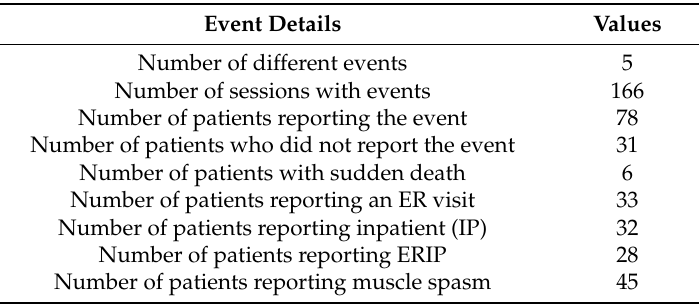
Table 2. Details of events reported during study